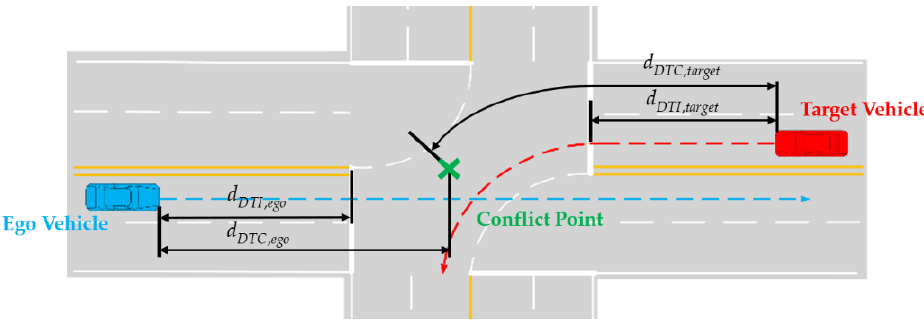
Figure 3. Safety indexes for intersection driving scenario.